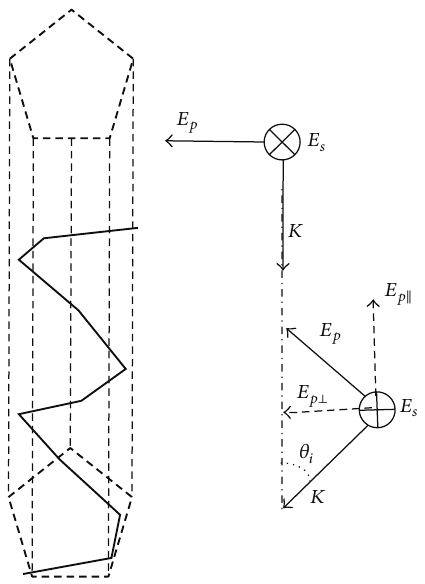
Figure 3: Schematic of chiral pentagon growth and the definition of the incident polarization directions and decomposition of the 𝑝 - polarized field by changing the incident light